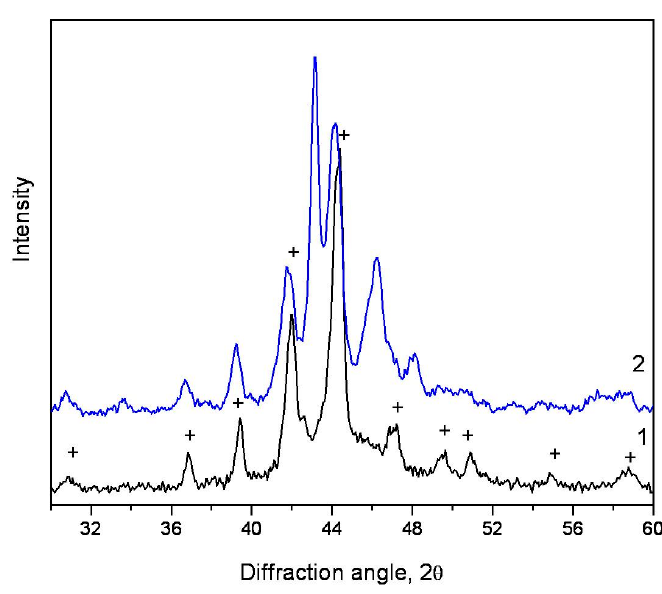
Figure 5. X-ray di ff raction patterns of the alloy after annealing at 750 (1) and 873 K (2) (Co K α Figure 5. X-ray diffraction patterns of the alloy after annealing at 750 (1) and 873 K (2) ( С o K α ).